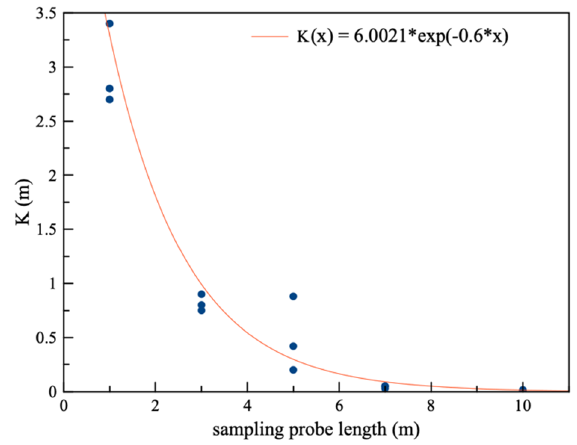
Figure 5. K value as a function of the sampling probe length. The red line draws the exponential best fit.